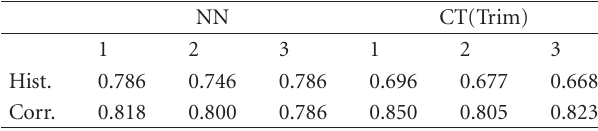
Table 4: Correctness classification on three data sets.